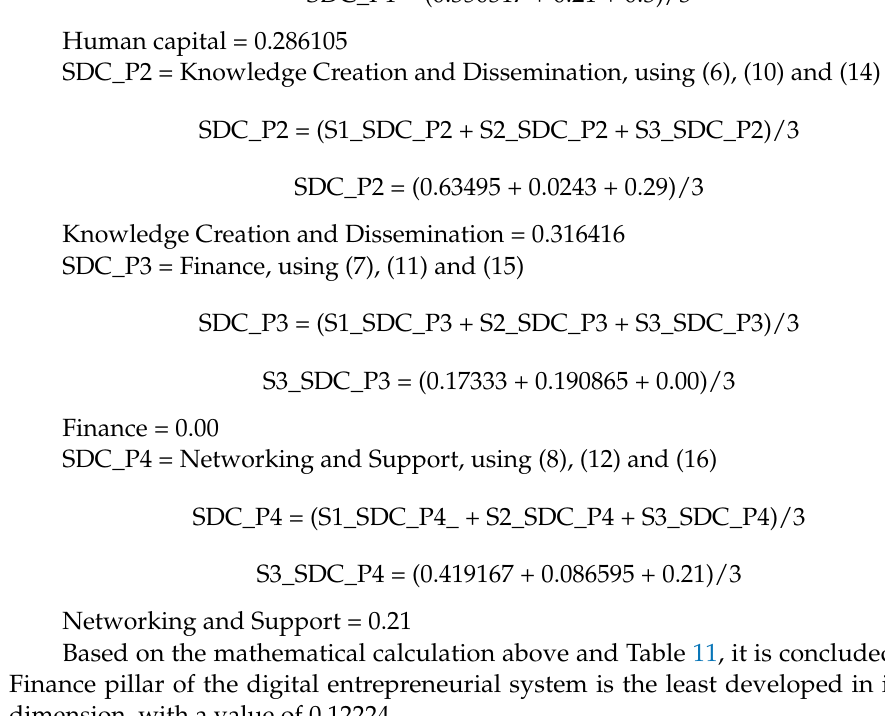
Table 11. The pillars of the digital entrepreneurial system of the Republic of Serbia, in their digital dimension, with the identification of the least developed